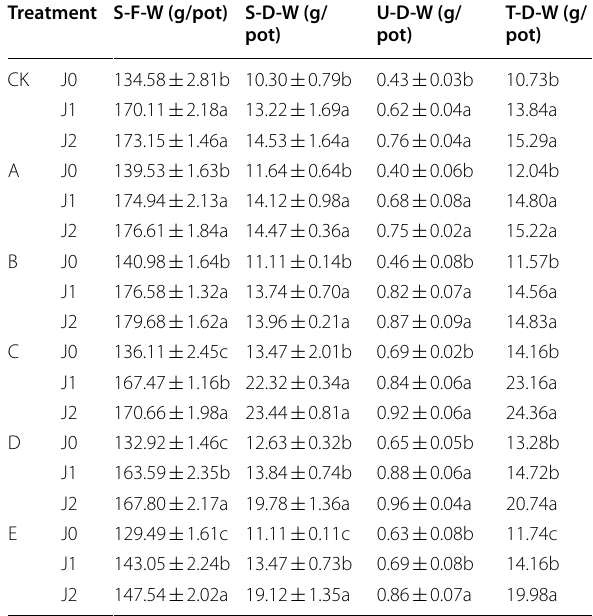
The data in Table 3 represent the biomass of each part of Sedum alfredii Hance at different Pb and Cd concentration treatments. Each abbreviation in the table indicates: S-F-W shoot fresh weight, S-D-W shoot dry weight, U-D-W underground dry weight, T-D-W total dry weight. The numbers after different letters in the same column of each treatment were significantly different ( P < 0.05)